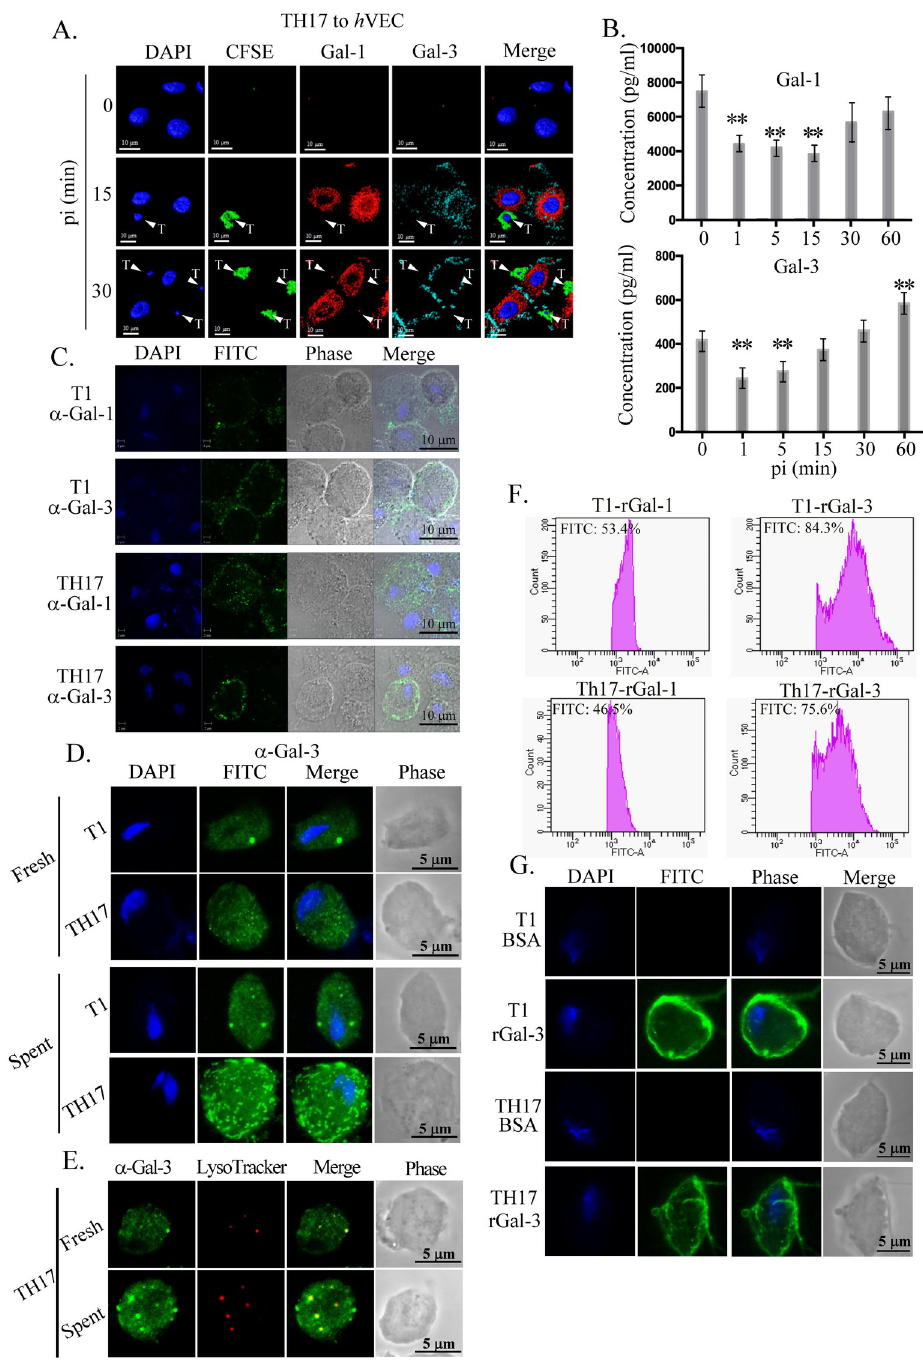
Fig 3. Involvement of galectins in the host-parasite interaction. A and B. Surface expression or secretion of galectins. CFSE-labeled TH17 trophozoites (green) were co-incubated with h VECs(moi 1:3) were sampled at intervals for the detection of galectin-1 (red) and galectin-3 (cyan) by IFA (A), while these galectins in the conditioned medium were detected by ELISA (B). PI, post-infection. Adherent trophozoites in A are indicated by white triangles. C, D, and E. T1 or TH17 trophozoites were incubated in fresh or conditioned KSFM (D) from h VECscultures for 30 min. Cells were fixed for detection of galectin-1 or -3 by IFA without permeation for (C) or with permeation for (D and E) before immune detection. E. IFA co-staining with anti-galectin-3 antibody and LysoTracker. F and G. T1 or TH17 trophozoites were incubated with FITC-conjugated recombinant galectin-1 or galectin-3 and analyzed by flow cytometry (F) or fluorescence microscopy (G). The bar graph is shown by mean ± SD. All assays were repeated three times and the representative data are shown here. Differences were statistically analyzed by Student’s t-test, with P < 0.01( �� ) and P < 0.05( � ).